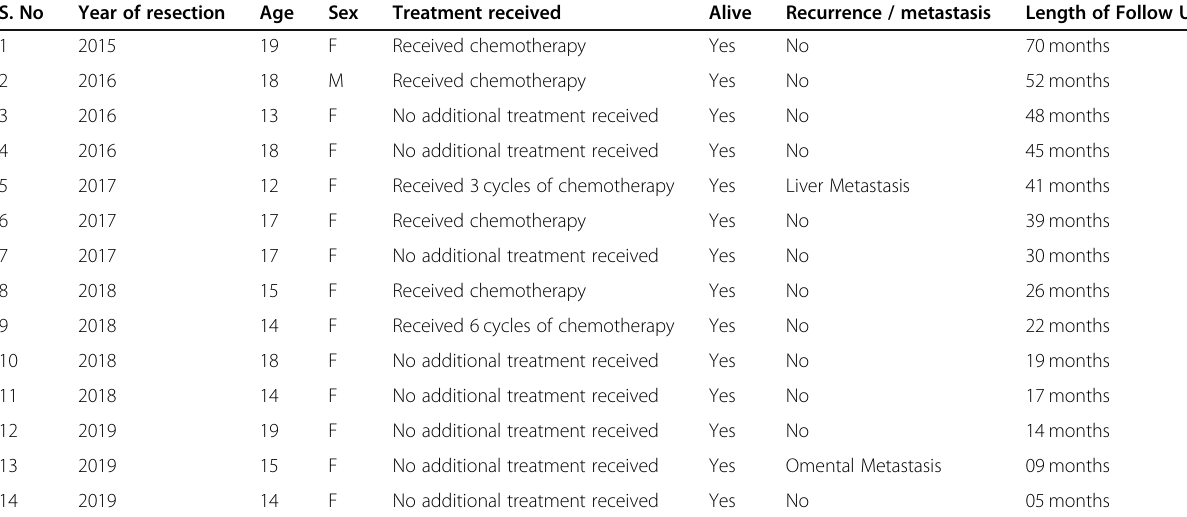
Table 4 Details of follow-up of SPN cases in patients under 20 years of age ( n =